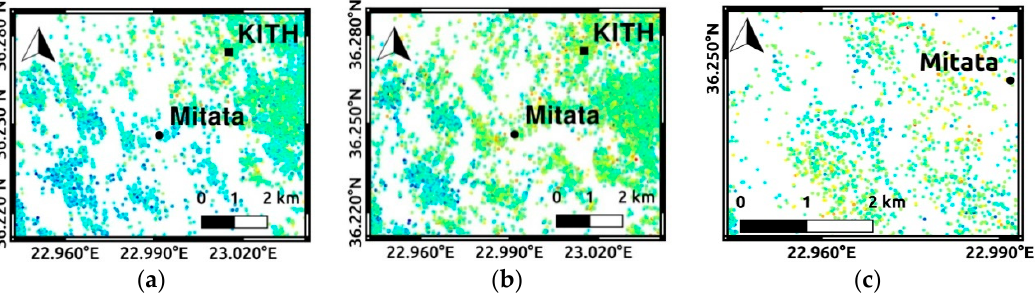
Figure 5. A closer view of PS scatterers in the center of the island to the west of the Mitata village, where positive LOS displacements are identified. ( a ) Sentinel-1 LOS displacements, ascending track no. 102; ( b ) Sentinel-1 LOS displacements, descending track no. 7; ( c ) Envisat LOS displacements, ascending track no.